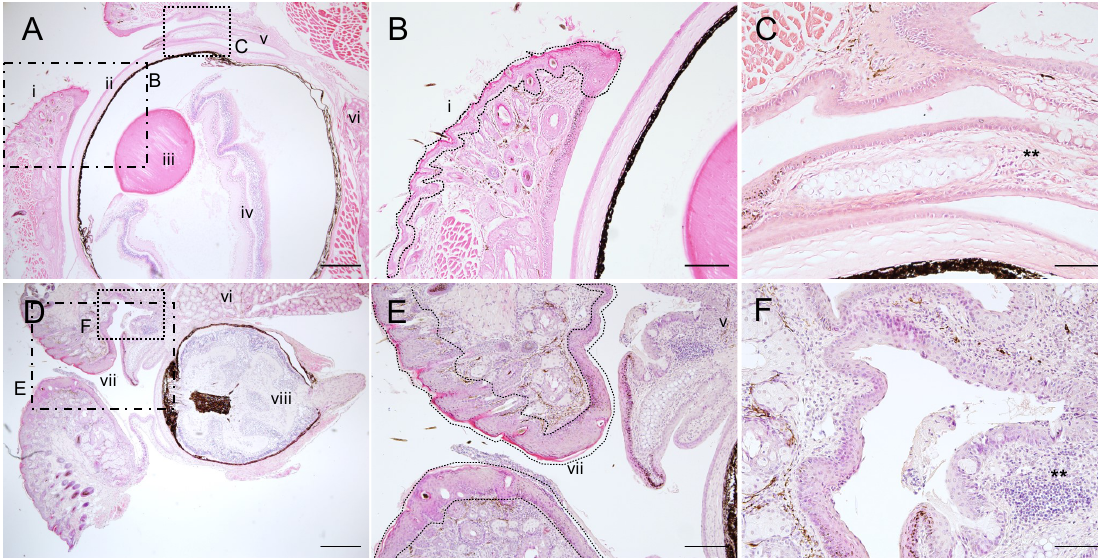
Figure 2. Representative images of inflammation in the eyelid and subsequent eye deformation in PG1 transgenic mice. Haematoxylin and eosin (H&E) staining of the eyelid and ocular regions from wild-type ( A – C ), abnormal PG1-TG ( D – F ). (i) eyelid in normal condition, (ii) cornea, (iii) lens, (iv) retina, (v) conjunctiva, (vi) Harderian gland, (vii) thickened eyelid epithelium, (viii) shrinking eyeball. The rectangular insets in figures ( A , D ) were enlarged in ( B , C , E , F ). The symbol ** in figure F indicates a cluster of infiltrated granulocyte-like cells. Scale bar represents 500 μm ( A , D ), 200 μm ( B , E ), and 50 μm ( C , F ), respectively.